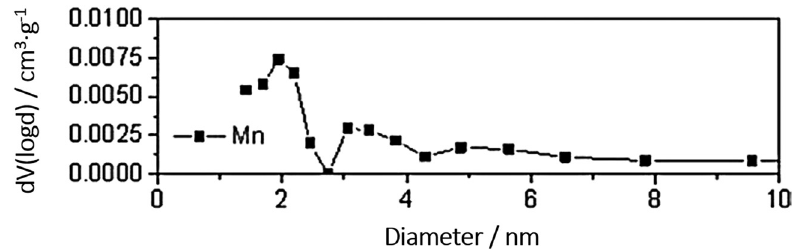
Figure 4: The mesopore size of Moso bamboo ( between 1.5 and 10 nm ) [ 4 ]